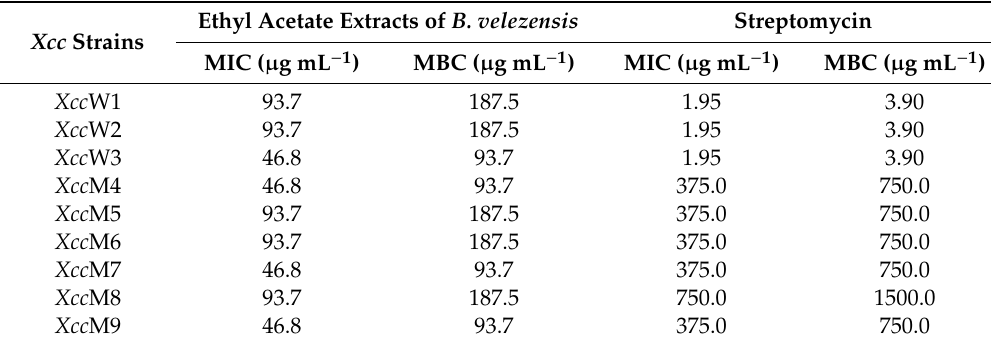
Table 3. MIC and MBC values of the ethyl acetate extract of B. velezensis and streptomycin against X. citri subsp. citri ( Xcc ) on YNA